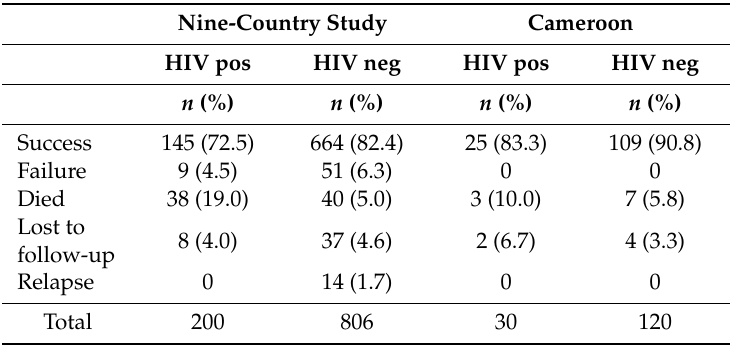
Table 6. Outcomes according to the HIV status among patients treated in the Nine-country and the Cameroon